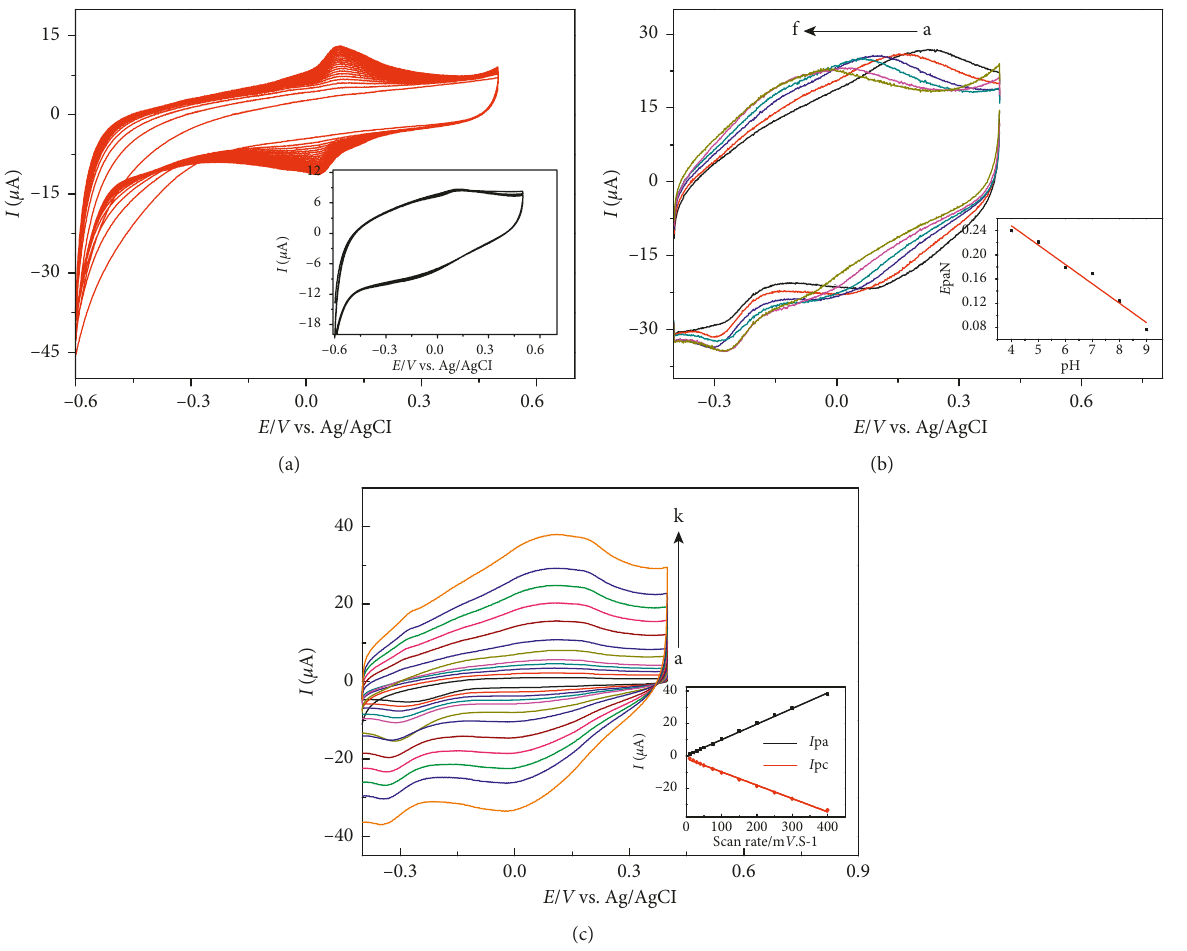
Figure 2: (a) CVs of the electropolymerization of CH onto the AGCE in 0.1M PBS (pH 7.0). Inset shows CVs for bare GCE. Scan rate: 100mV/s. (b) CV of the PCH/AGCE in PBS with different pH values ( a – f : 4.0, 5.0, 6.0, 7.0, 8.0, and 9.0). Scan rate:100mV/s. (c) CVs of the PCH/AGCE in 0.1M PBS (pH 7.0) at various scan rates ( a – k :10, 20, 30, 40, 50, 75, 100, 150, 200, 300, and 400mV/s). Inset shows plots of I pa and I pc ( μ A) versus the scan rate (mV/s) U+002e.